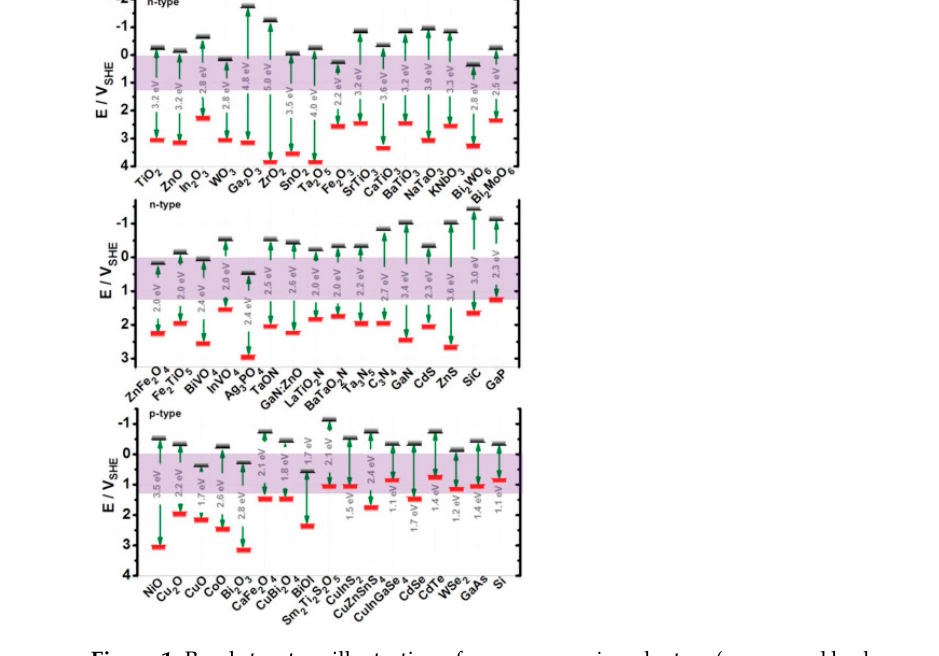
Figure 1. Band structure illustration of common semiconductors (vs. normal hydrogen electrode) [19].